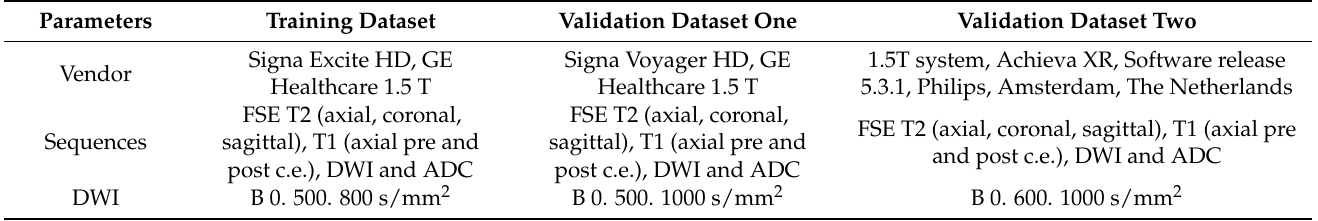
Table 1. Acquisition parameters of the three magnetic resonance imaging vendors used in the three